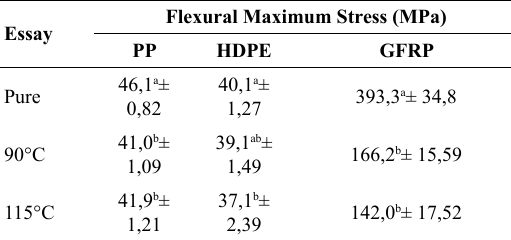
Figure 10. Infrared spectrum for pure GFRP, 90° GFRP and 115° Table 4. Results of flexural strength for the materials studied.